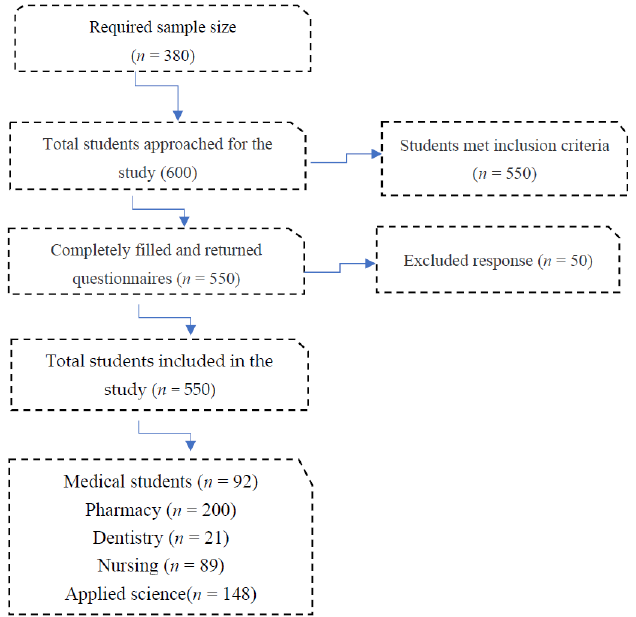
Figure 1. Flowchart of the responses.